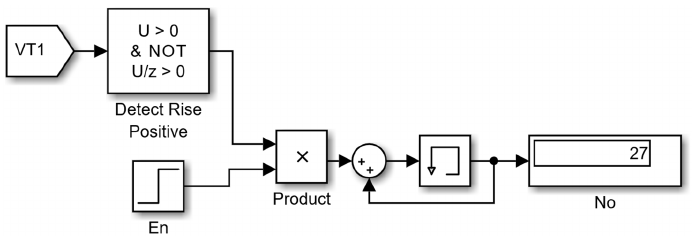
Figure 6. Flowchart to determine the number of transistor switches.